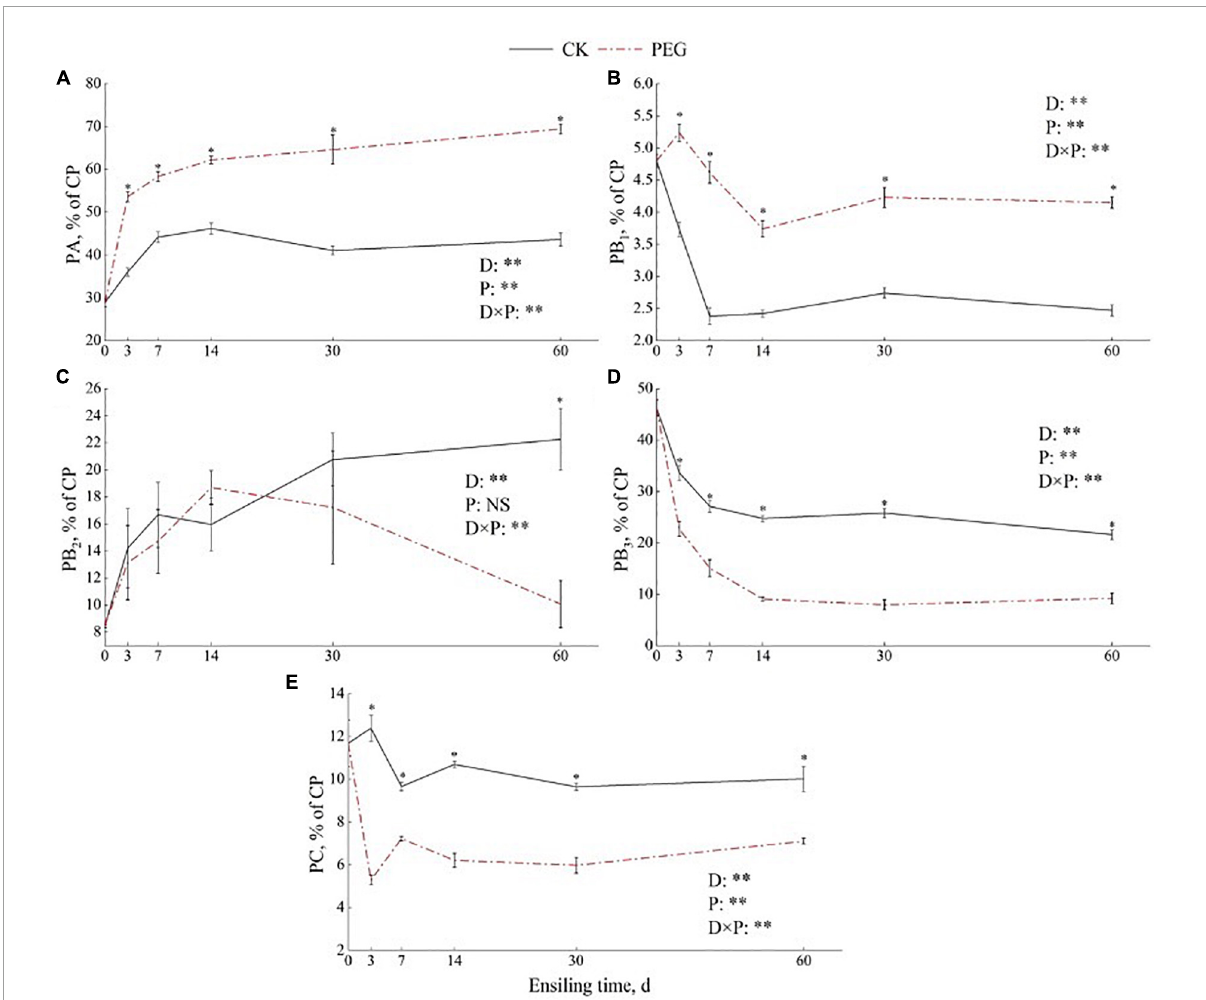
FIGURE1 Effect of intrinsic tannins on protein fraction of (A) PA, (B) PB 1 , (C) PB 2 , (D) PB 3 , and (E) PC during sainfoin ensiling. PA (% CP) = NPN (% SOLP) × 0.01 × SOLP (% CP); PB 1 = SOLP (% CP)-PA (% CP); PB 2 = 100-PA (% CP)-PB 1 (% CP)-PB 3 (% CP)-PC (% CP); PB 3 = NDIN (% CP)-ADIN (% CP); PC = ADIN (% CP). PEG, polyethylene glycol. D = effects of ensiling days; P = effects of addition with PEG. D × P = effects of interaction between ensiling days and PEG treated. Error bars mean SEM. Asterisks ( ∗ p < 0.05, ∗∗ p < 0.01) indicate that there was a significant difference between the control and PEG-treated